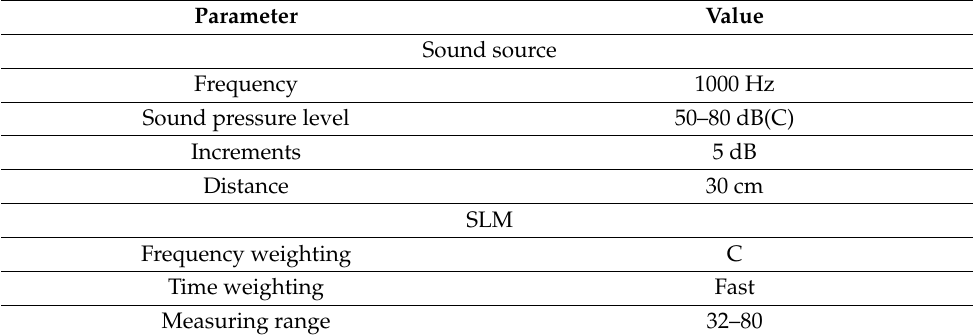
Table 4. Settings for the